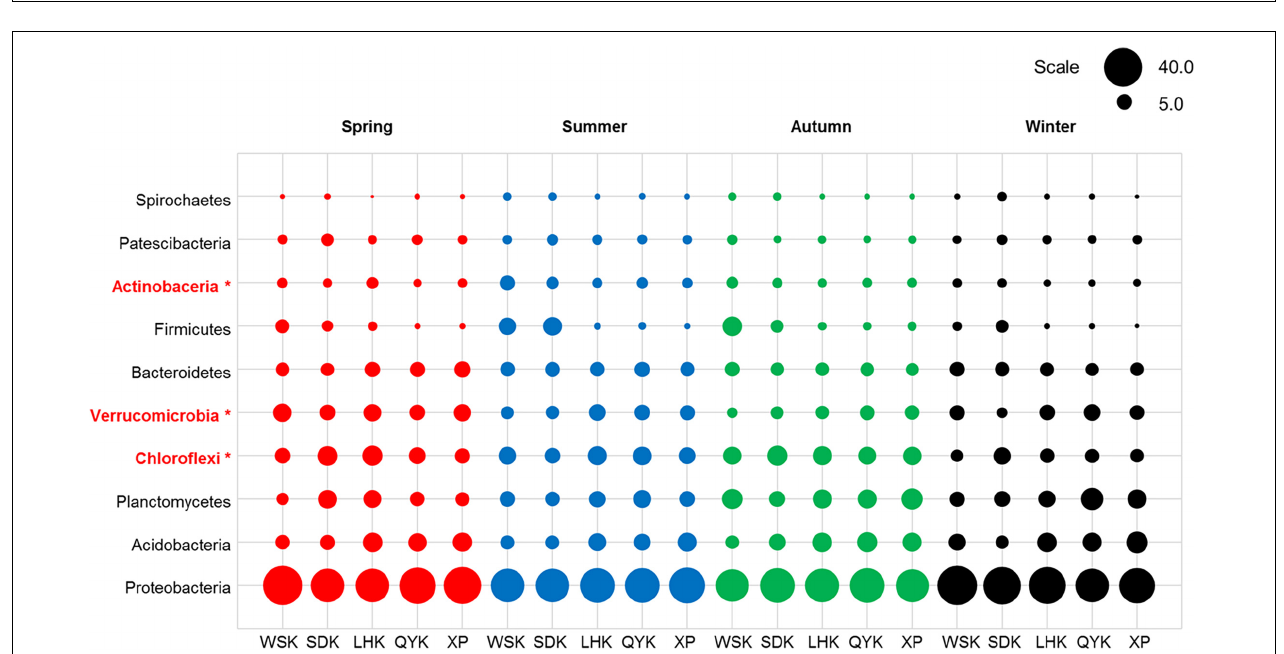
FIGURE 2 | The unweighted UniFrac principal coordinate analysis (PCoA) of microbial communities in intertidal sediments of Yangtze River estuary, among different (A) seasons and (B) precipitation (dry/wet season). Significant difference was identified using Adonis test in PERMANOVA, P < 0.05.